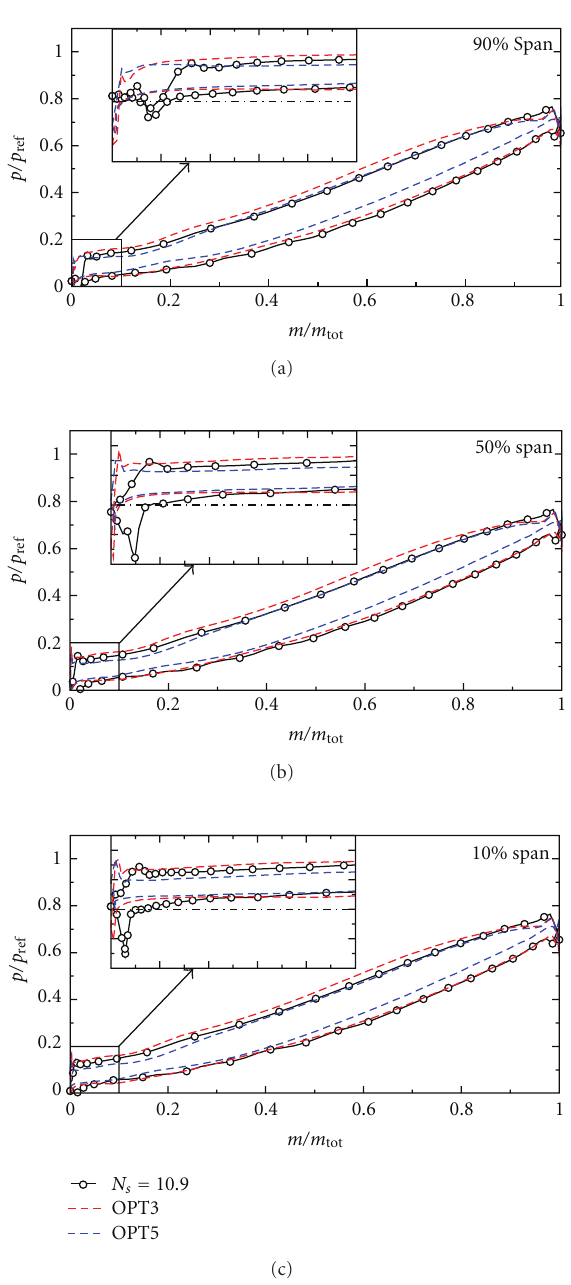
Figure 12: Pressure distributions at BEP for three di ff erent spans, N s = 9 . 5 (OPT3-OPT5) and N s = 10 . 9